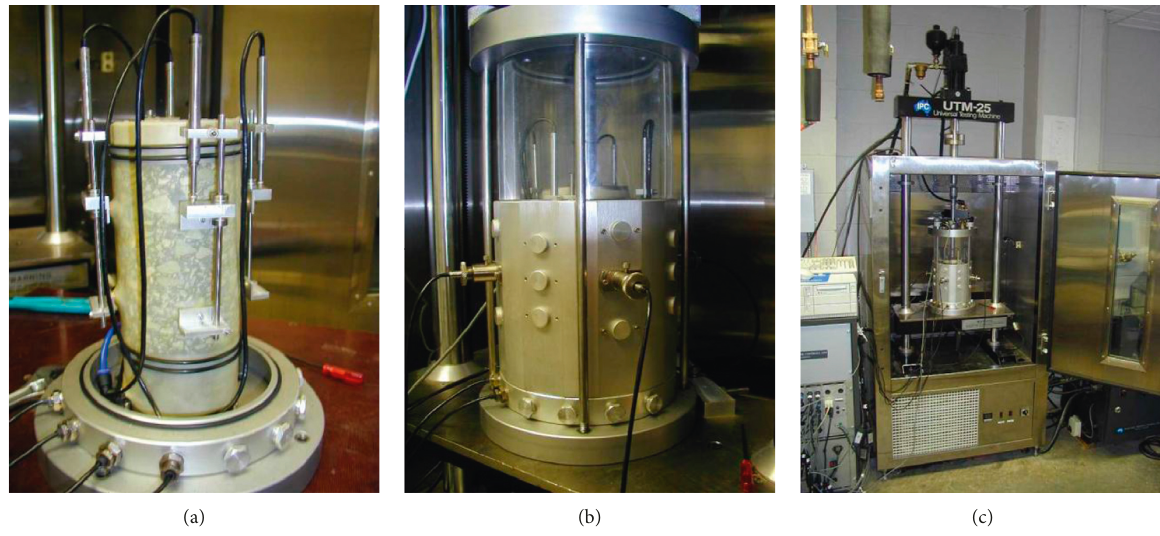
Figure 3: (a) Instrumented TRLPD specimen, (b) triaxial cell, and (c) UTM-25